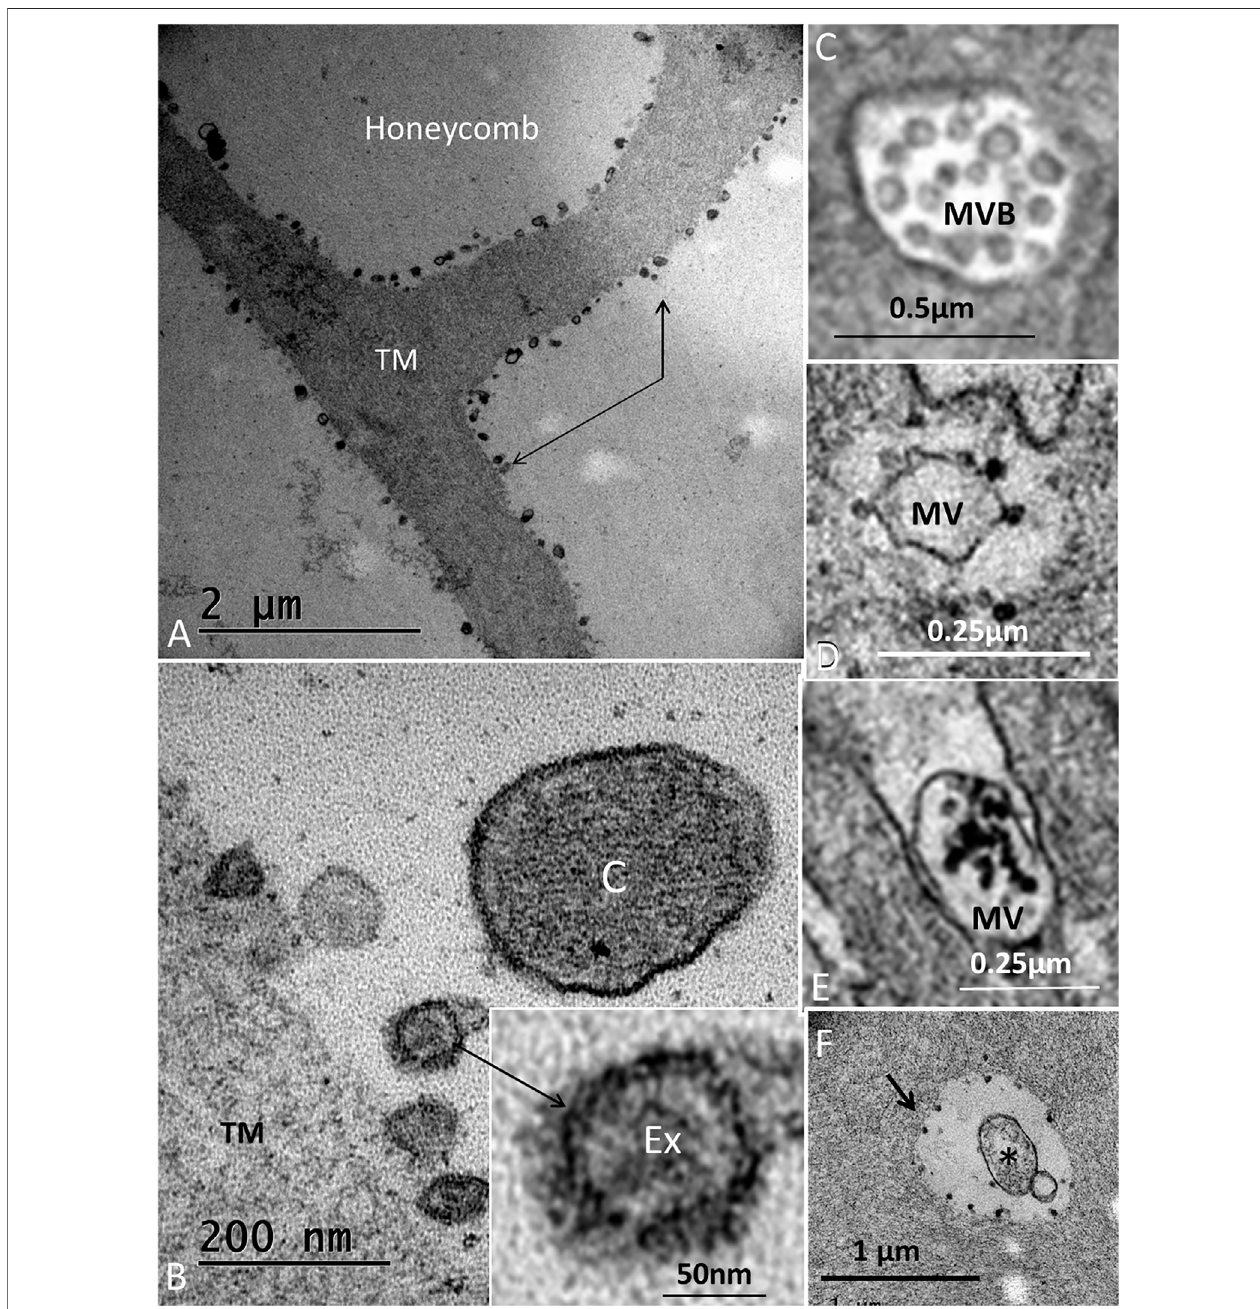
FIGURE 11 | (A) . Electron microscopy of the honeycomb layer near the sensory cells. The beams are outlined by hollow electron-dense granules (indicated by arrows). (B) . Higher magni fi cation shows membrane-bound exosome-like bodies (Ex) further magni fi ed in the inset. (C) cilium. (C) . MVB located in the HoC. (D) . Microvesicle in the apical cytoplasm of an HoC is surrounded by electron-dense bodies. (E) . Microvesicle expelled in the endolymph located between apical projections containing electron-dense bodies. (F) . Similar bodies outline a vacuole in the TM (arrow). *: apoptotic microvesicle.